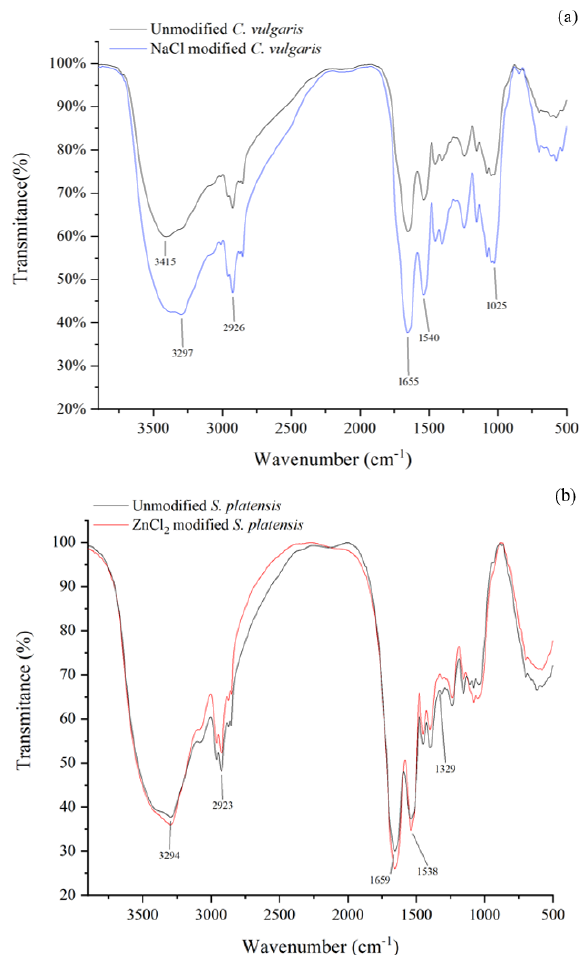
Figure 6. FTIR spectra of ( a ) C. vulgaris and ( b ) S. platensis before and after modification.